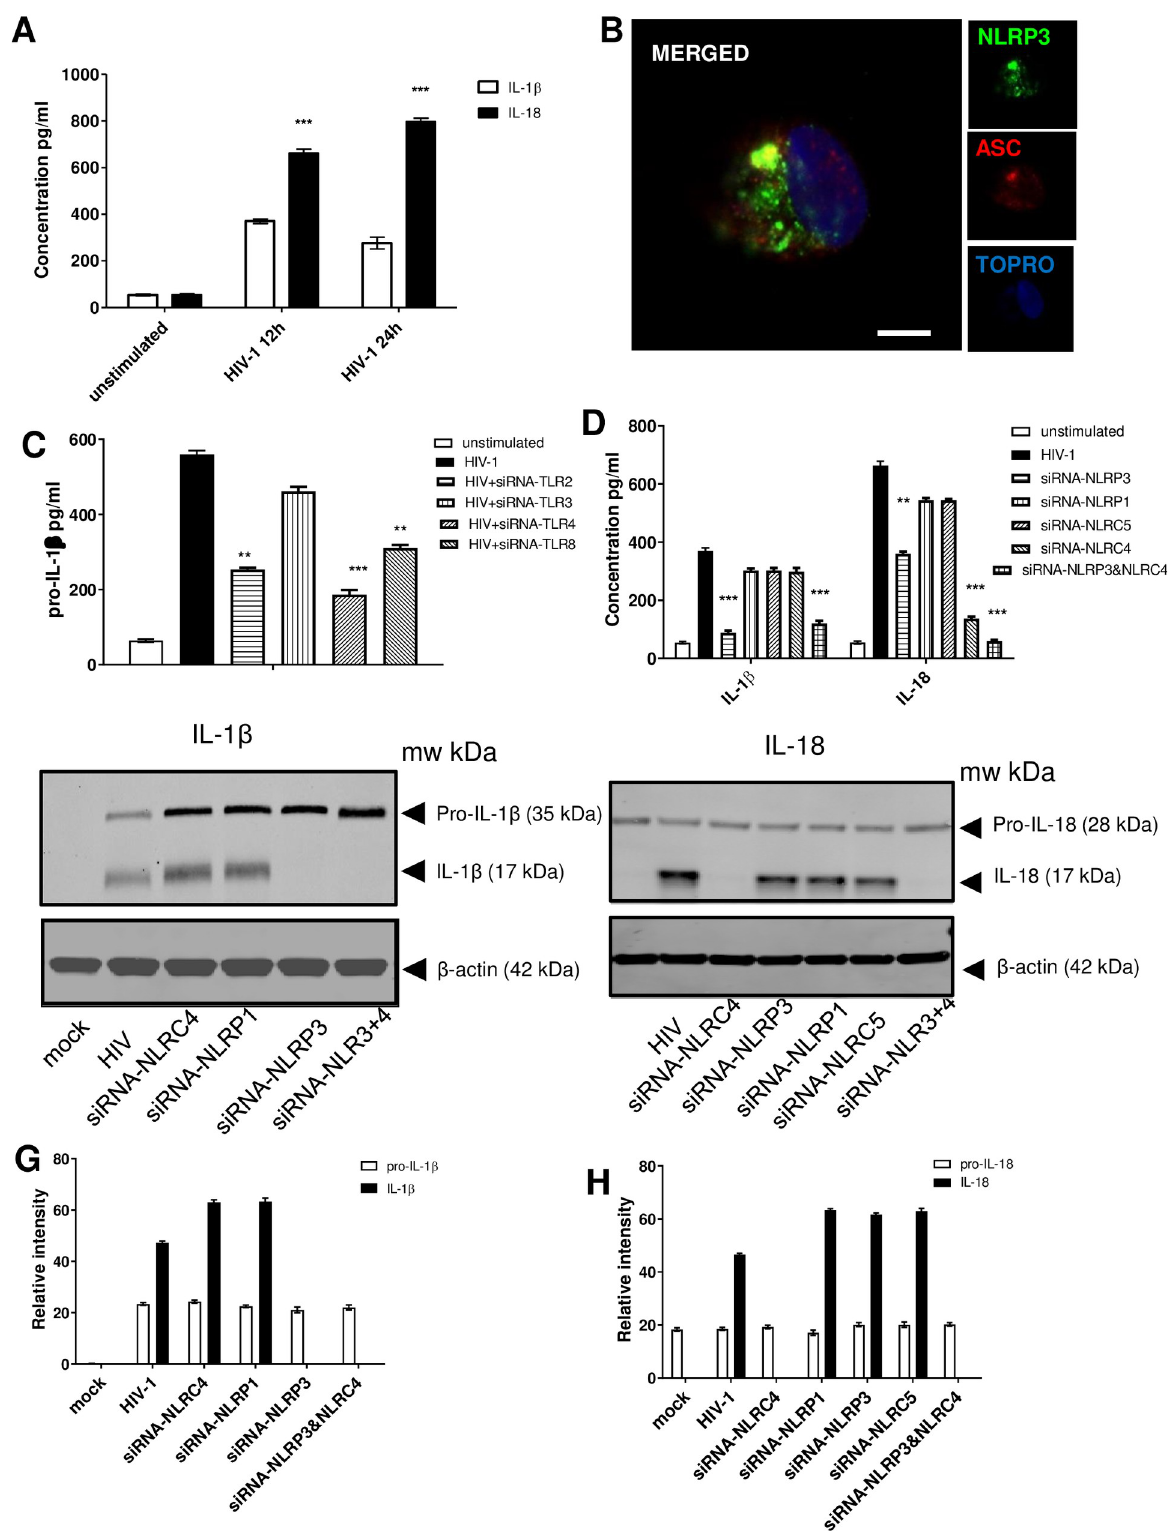
Fig 1. IL-1 β and IL-18 secretion in HIV infection are differentially controlled. Monocyte derived macrophages (MDMs) (1 x 10 6 ) were infected with HIV-1 (MOI = 1) or left untreated for 12hr and 24hr. Supernatant was collected post infection and analysed for IL-1 β and